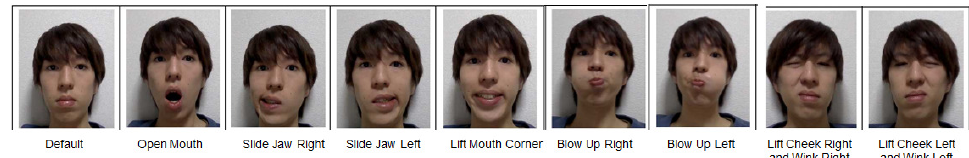
Figure 8. Types of gestures. Reprinted/adapted with permission from Ref. [11] 2021,